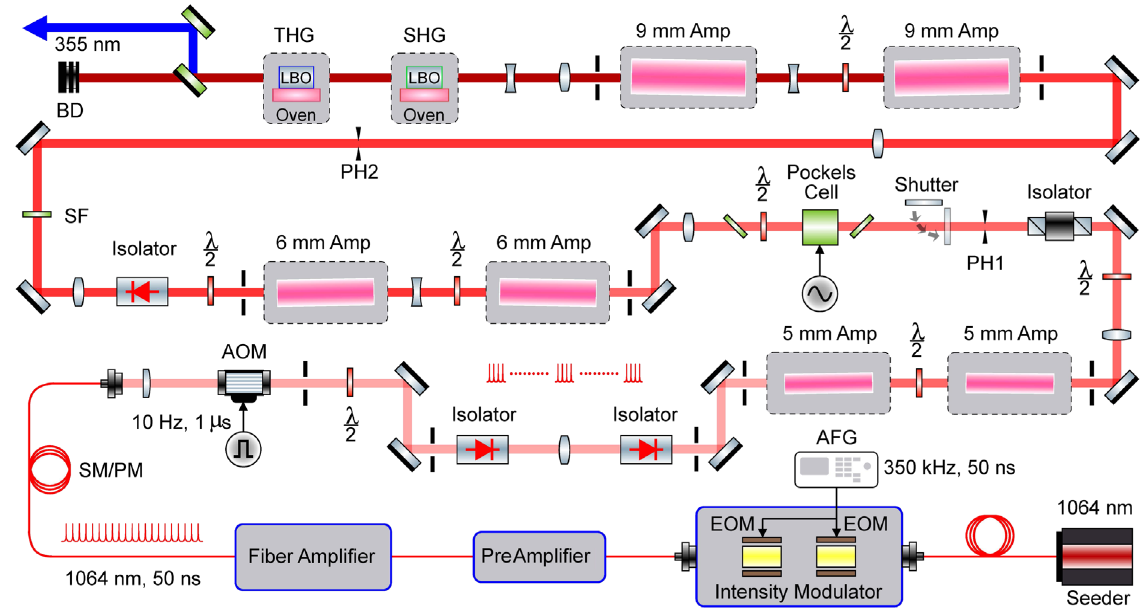
FIG. 7. Overview of the 50 ns laser system. AFG, arbitrary waveform generator; EOM, electro-optic modulator; AOM, acousto-optic modulator; λ = 2 , half-wave plate; SM/PM, single-mode polarization-maintaining fiber; SF, spatial filter; PH, pinhole; LBO, lithium triborate; SHG, second-harmonic generation crystal; THG, third-harmonic generation crystal; BD, beam